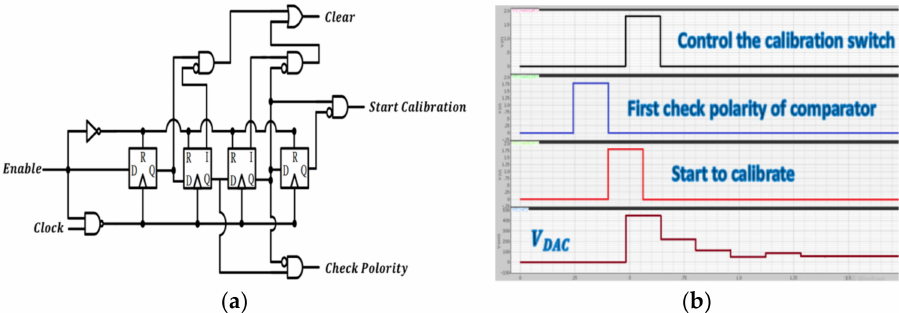
Figure 15. ( a ) Logic gate diagram of the control signal generator; ( b ) transient simulation of the control signal circuit. Enable, the enable signal; Clock, the clock signal; Start Calibration, output the calibration signal; Check Polarity, output the polarity of the comparator.